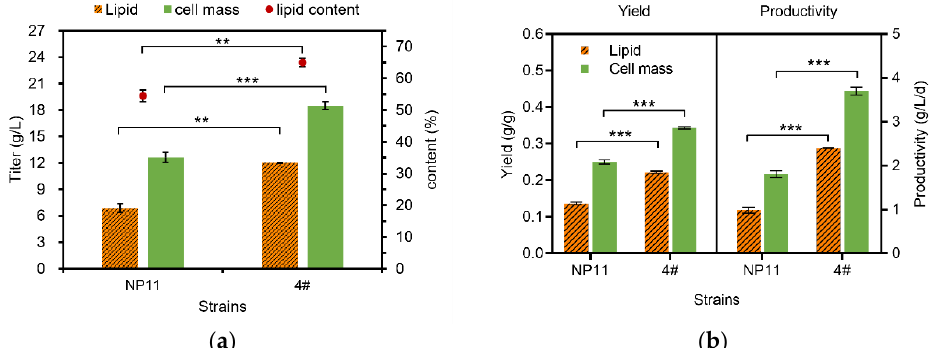
Figure 2. Lipid production results of R. toruloides NP11 and 4#. ( a ) Lipid and cell mass titer, and lipid content of strain NP11 and 4#. ( b ) The comparison of lipid and cell mass yield and productivity of the two strains. *** p < 0.001 ( p -value); ** p < 0.01; of the one-tailed Student’s t -test. All data are presented as mean ± SD of biological triplicates.